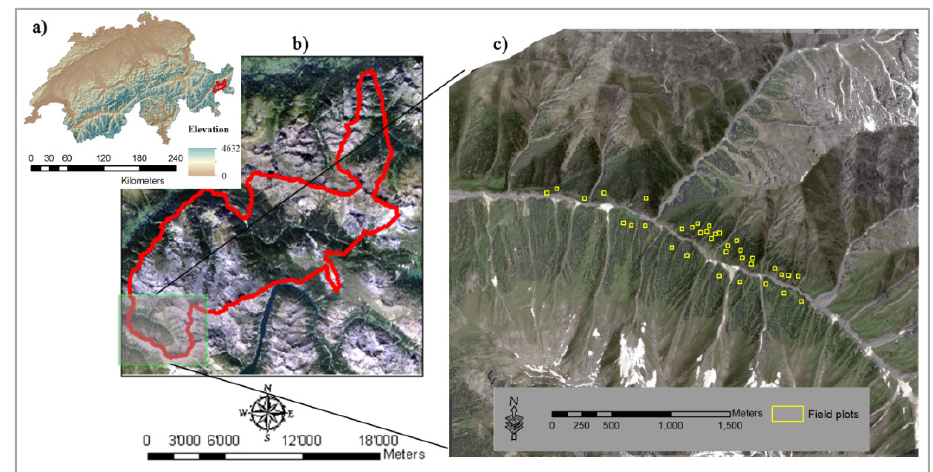
Figure 1. Study area and location of field plots. ( a ) Location of the SNP (Swiss National Park) (red line) with digital elevation model as background (source: swisstopo http://www.swisstopo.admin.ch). ( b ) Location of Val Trupchun (green box) within the SNP; a true color image is used as background (source: swisstopo). ( c ) Location of field plots (yellow boxes) in Val Trupchun; an APEX (Airborne Prism Experiment) true color image is used as background.